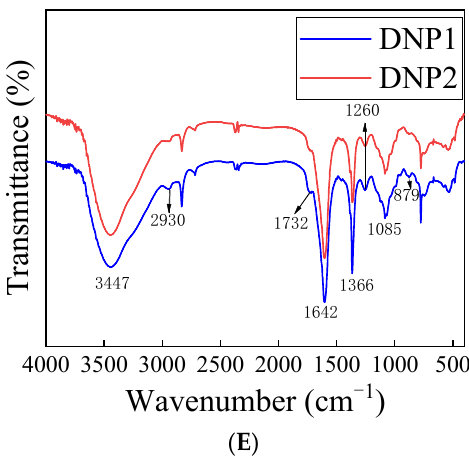
Figure 3. Elution curve of DNPs by Sephacryl S-300 HR ( A ), molecular weight distribution of DNP1 ( B ) and DNP2 ( C ), UV absorption spectrum ( D ), Fourier infrared spectroscopy ( E ).